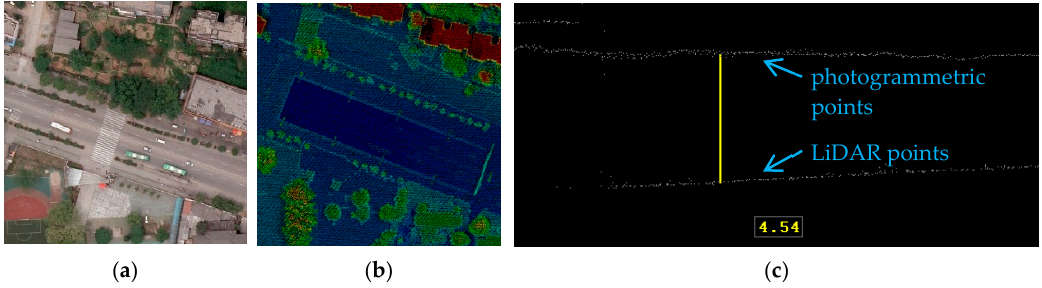
Figure 12. Examples of omissions for positive change: ( a ) buildings with complex structures of roof; Figure 13. A newly built underground passage results in the subsidence of ground: ( a ) aerial images ( b ) buildings covered by clutter objects; and ( c ) buildings covered by vegetation. of this area; ( b ) LiDAR data of this area; and ( c ) the subsidence of ground.